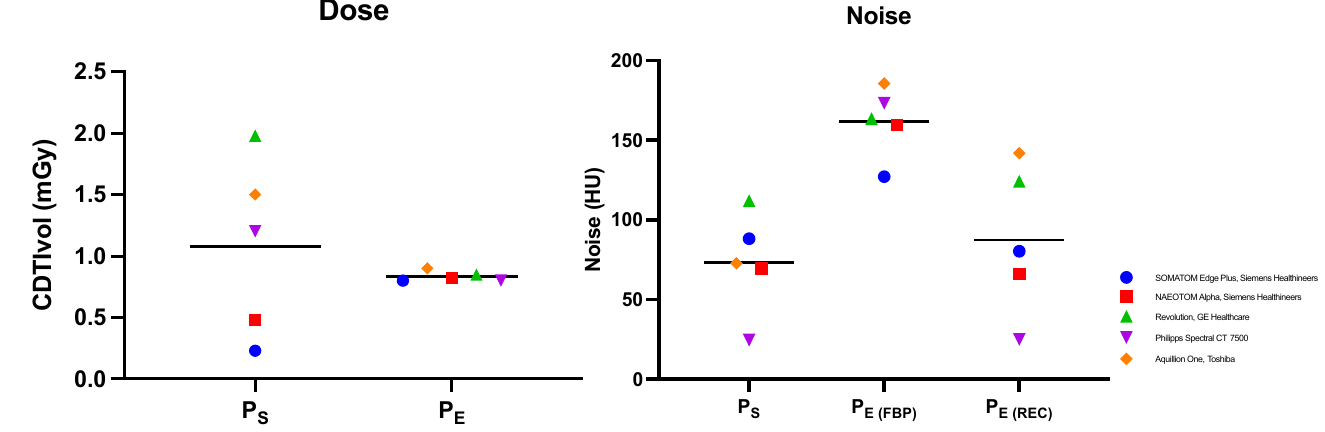
Figure 2. Comparison of radiation dose and image noise exposure. Observed mean dose (CDTIvol) and image noise (HU, Hounsfield Units) comparison between institute-specific standard low-dose protocols (P S ) and ESTI protocols (P E ) reconstructed with filtered back projection (P E(FBP) ) as well as with iterative reconstruction (P E(REC) ). The colors and shapes designate the CT scanner’s model and manufacturer.